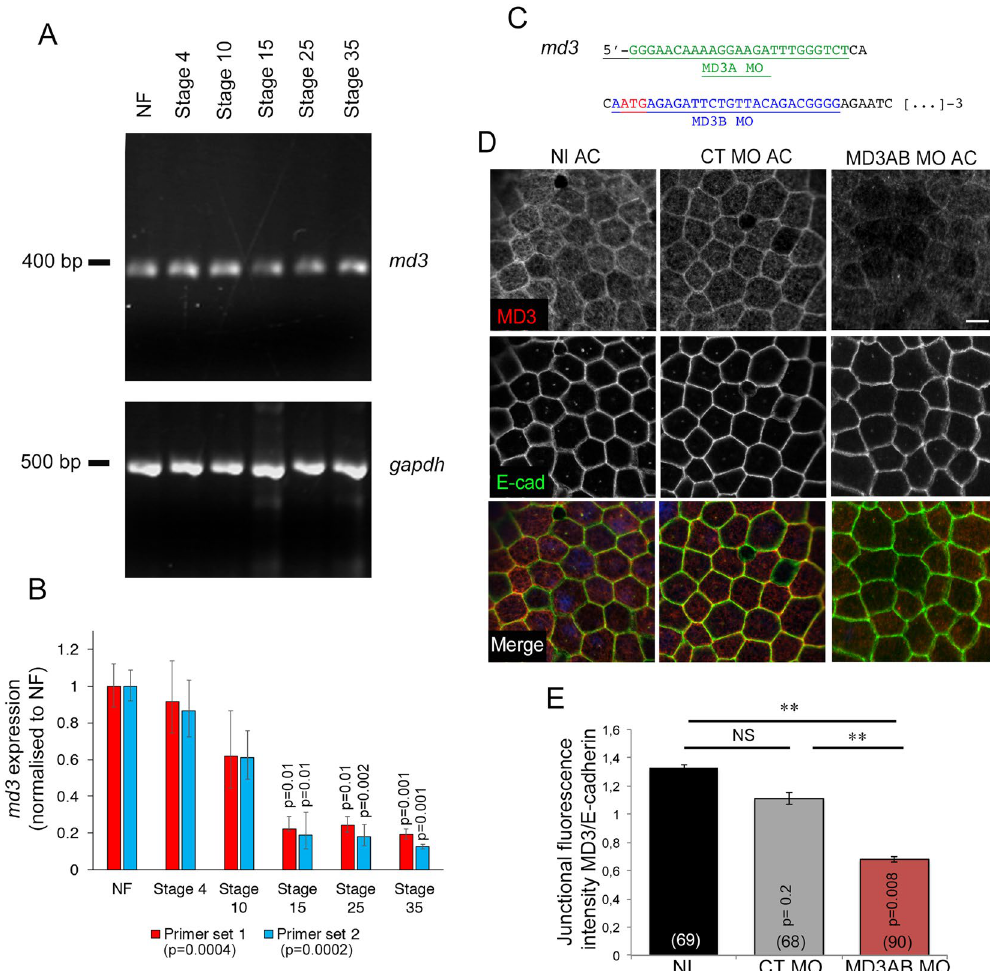
Figure 1. Marveld3 expression during Xenopus embryogenesis and morpholinos efficiency. ( A ) Analysis of marveld3 transcript expression by semi-quantitative RT-PCR in non-fertilized eggs (NF) and whole embryos from stage (St) 4 to 35; gapdh expression was used as a positive control; bp: base pairs. ( B ) Quantification of marvelD3 expression levels. Quantitative PCR was performed with two different sets of primers for marvelD3 and a pair of primers amplifying odc as a normaliser. Shown are means ± 1 SD of measurements with three independent mRNA isolations per developmental stage. ANOVA values are provided in the graph legend. The indicated p-values in the graph were calculated with t-tests comparing to the corresponding NF values. ( C ) MD3A (green) and MD3B (blue) morpholino sequences are indicated in the 5 ′ -end of the Xenopus marveld3 sequence; the start codon is indicated in red. ( D ) Analysis of MarvelD3 depletion by immunofluorescence was performed in animal caps derived from stage 8 embryos that had been injected with control or MD3AB morpholinos into both blastomeres at the 2-cell stage. MarvelD3 (red) and E-cadherin (adherens junction marker; green) expression was analyzed by immunofluorescence in animal caps explants. Scale bar, 100 μ m; NI, non-injected embryos. ( E ) Ratio of fluorescence intensity at junctions for MarvelD3 and E-cadherin. Mann Whitney test p values are on the graph; the number of cells counted is indicated in brackets on the graph bars; black bar, NI animal caps; grey bar, control morpholino- and red bar, MD3AB morpholino-injected animal caps; red bar, MD3AB morpholino-injected animal